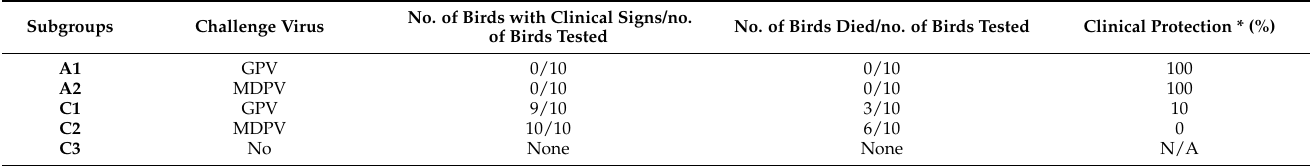
Table 5. Efficacy of bivalent vaccine in MDA-free Muscovy ducks—Protection against challenge. Challenge Virus